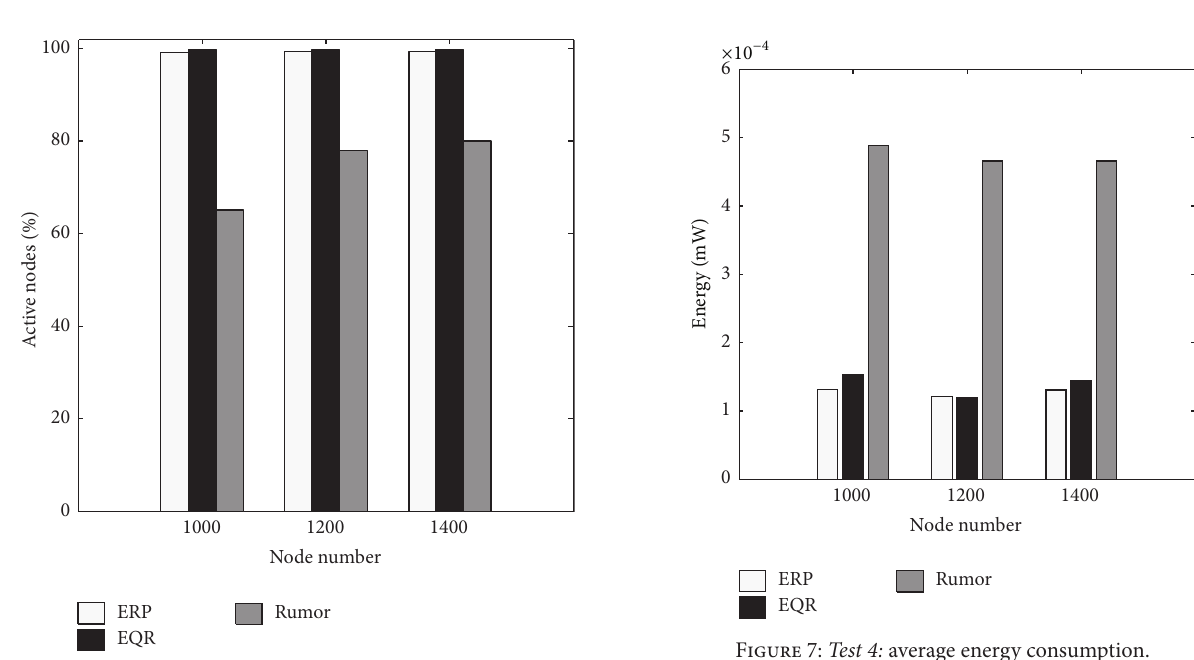
Figure 5: Test 2: fraction of active nodes.